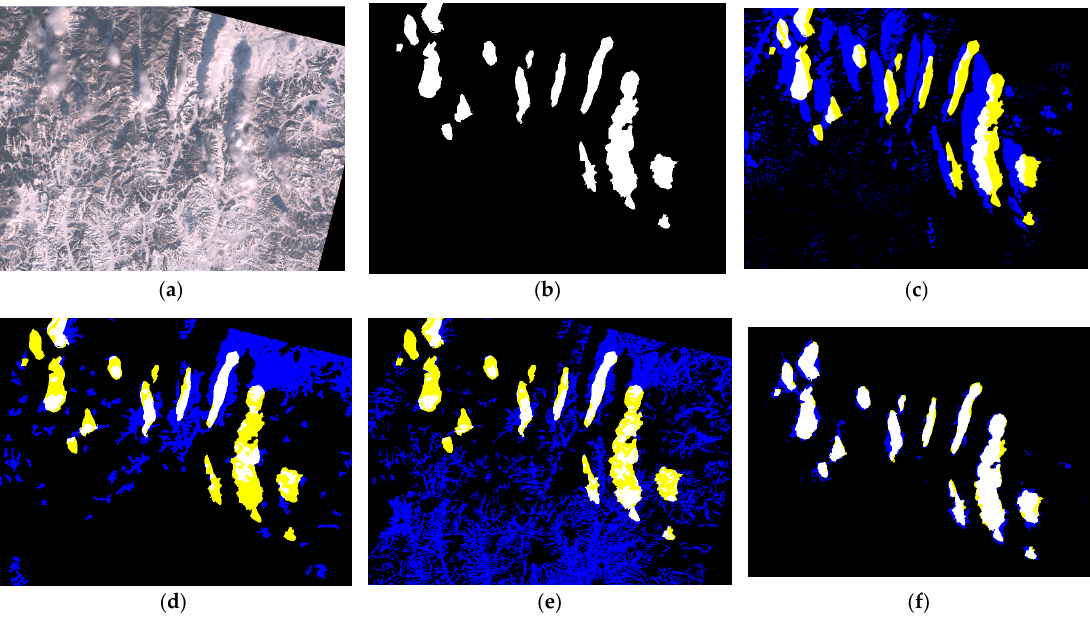
Figure 5. Detail comparison of different algorithms (the yellow area in the figure indicates the missed detection pixels and the blue area indicates the incorrectly detected pixels). ( a ) True-color image of subregion A. ( b ) Subregion A ground truth map. ( c ) Fmask algorithm cloud detection results for subregion A. ( d ) MFC algorithm cloud detection results for subregion A. ( e ) CSD-SI algorithm Cloud detection results for subregion A. ( f ) Our algorithm cloud detection results for subregion A.